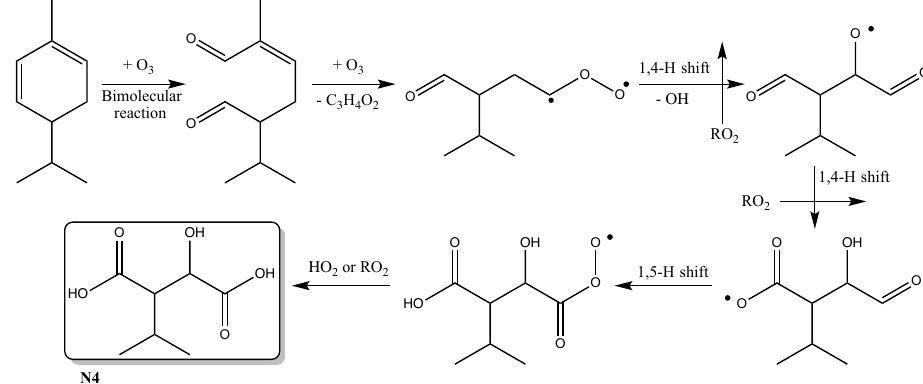
Figure 3. Proposed formation mechanism of compound N4. N5 is formed through an analogous mechanism starting with initial attack of ozone at the more substituted double bond. The vertical arrow with RO 2 denotes a peroxy radical self-reaction to form an alkoxy radical.